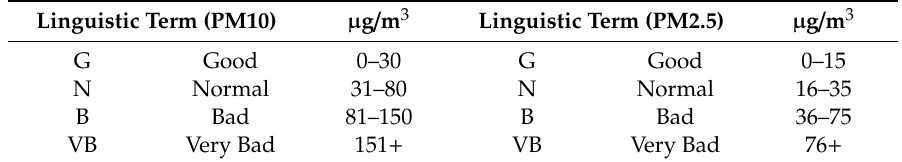
Table 2. Particulate matter (PM) classification criteria established by the Korea Ministry of Environment (KME).